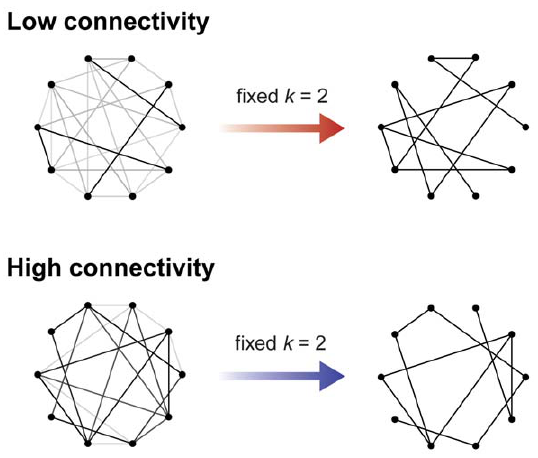
Figure 2. Imposing a fixed average degree can modify network structure. Applying a variable threshold to obtain a fixed average degree ( k ) may have consequences for the resulting network structure. A relatively large average degree for a network with low overall connectivity will convert non-significant values into edges. By contrast, a relatively small k for a network with high overall connectivity will omit a number of significant connections. Connectivity strength is indicated using a gray scale with black indicating strong (significant) connections.